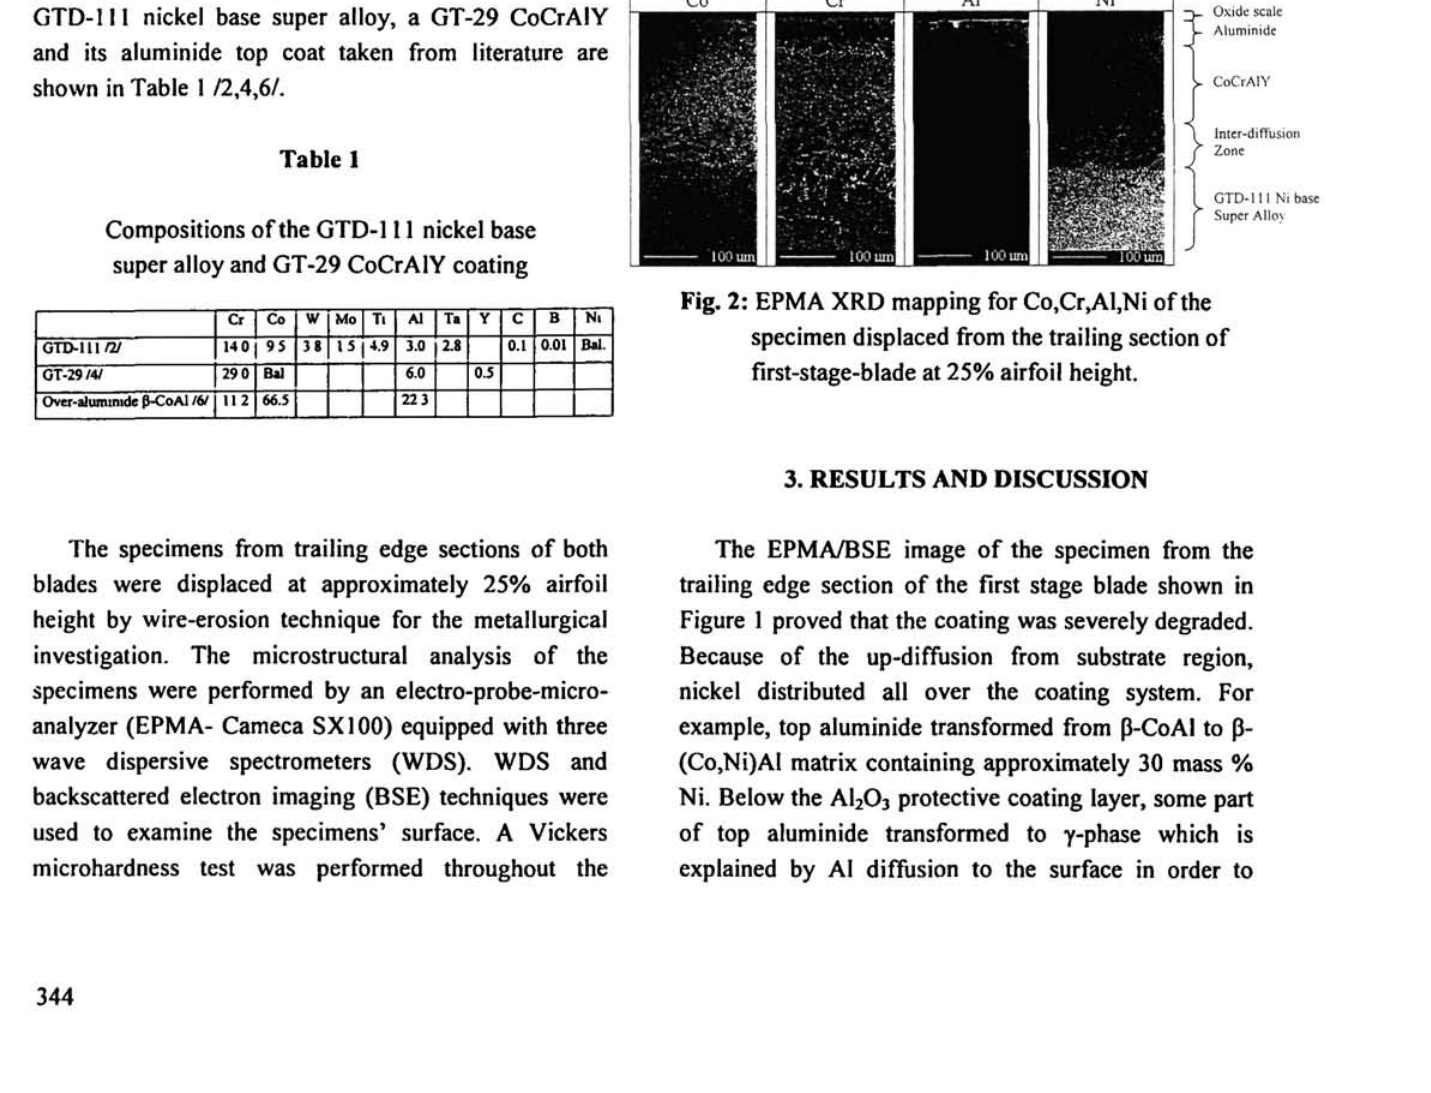
Fig. 2: ΕΡΜΑ XRD mapping for Co,Cr,Al,Ni of the specimen displaced from the trailing section of first-stage-blade at 25% airfoil